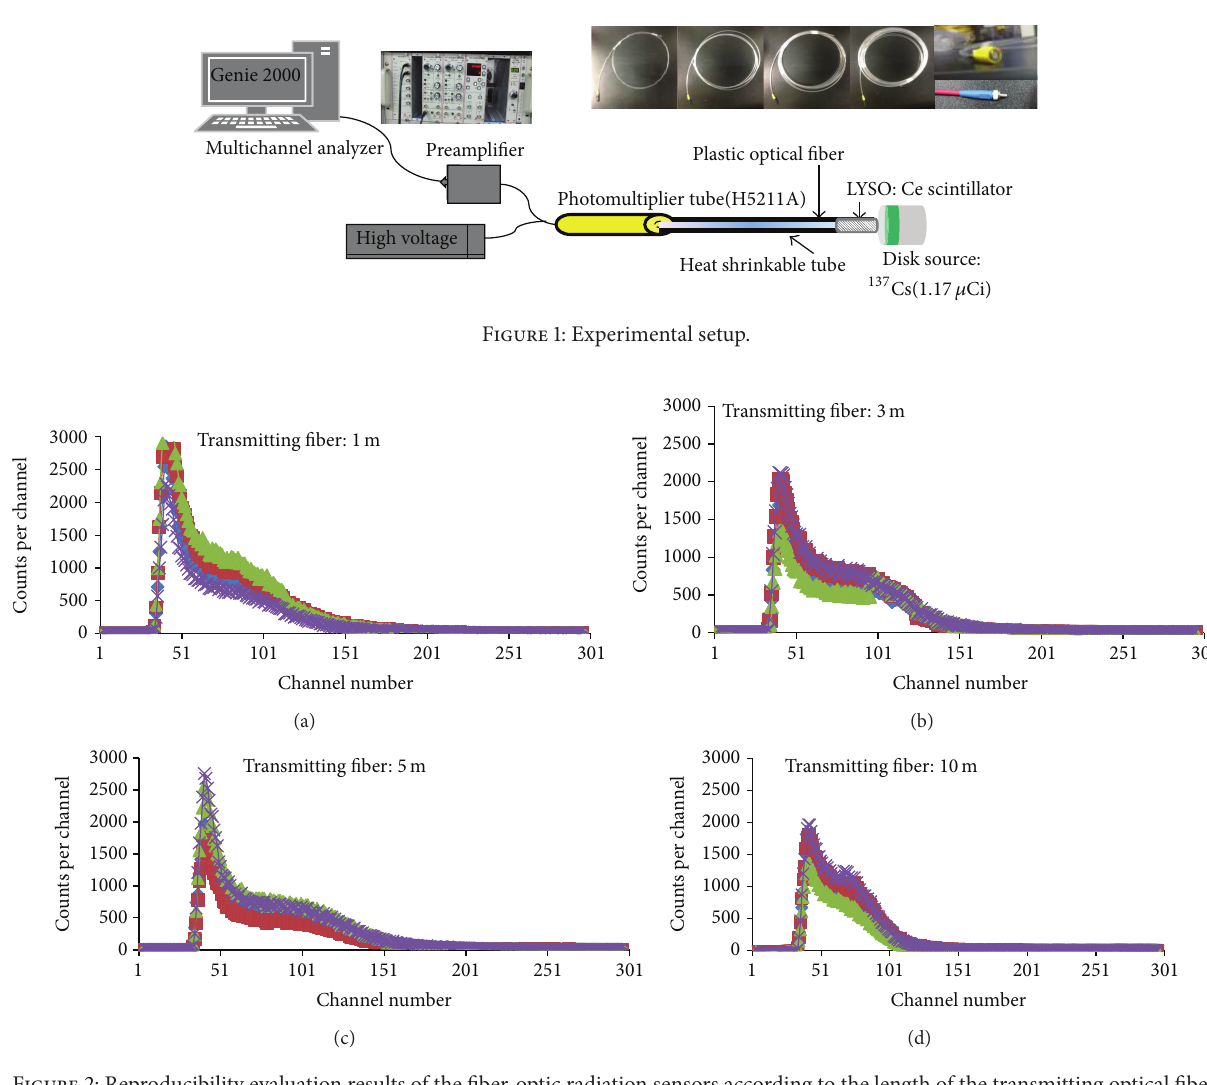
Figure 2: Reproducibility evaluation results of the fiber-optic radiation sensors according to the length of the transmitting optical